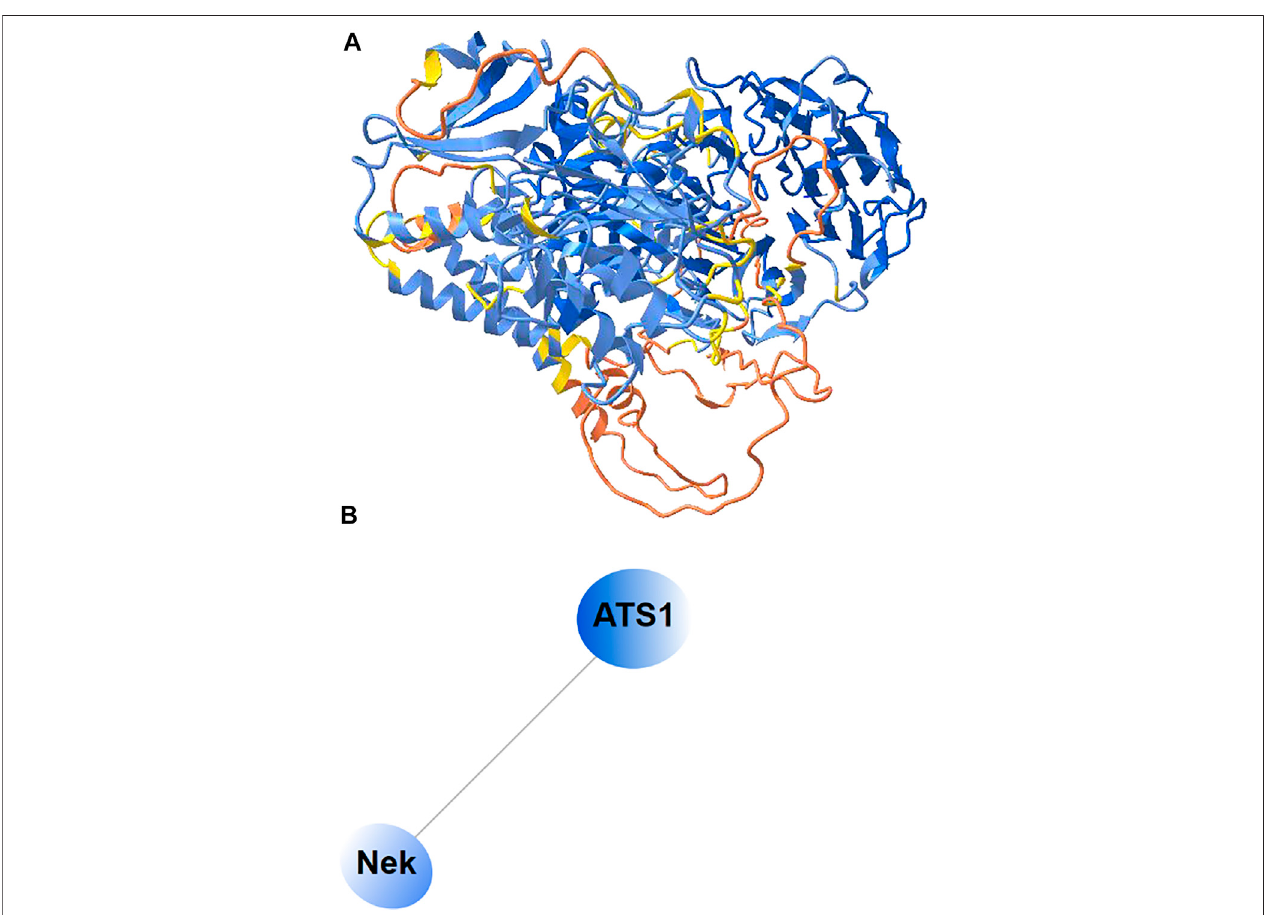
FIGURE 7 | 2D Cartoons of an AlphaFold structure. (A) AlphaFold predicted structure for the UniProt ID A0A061AD48. The high con fi dence parts of the structure are colored in blue and the low con fi dence parts are colored in yellow and orange. (B) 2D cartoon in the domain level. There are two domains in the protein: Nek and ATS1. (C) The Nek domain of the structure. (D) 2D cartoon at the secondary structure level. Helices are solid cylinders and labeled as “ H ” plus the fi rst residue number. Sheetsareempty cylindersandlabeledas “ S ” plusthe fi rstresiduenumber.ThesharablelinkforpanelsAandBis:https://structure.ncbi.nlm.nih.gov/icn3d/share.